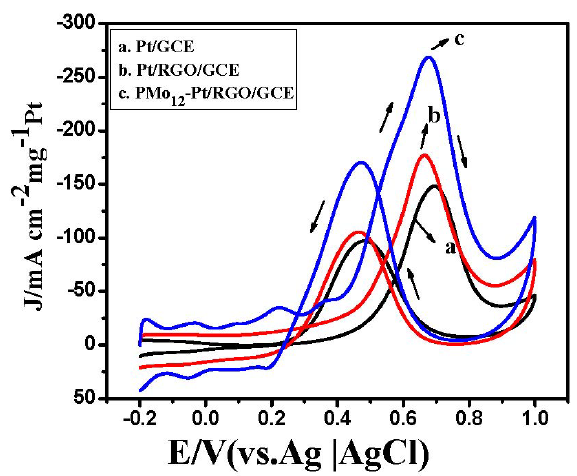
Figure 6. Cyclic voltammograms of different modified electrodes: ( a ) Pt/GCE; ( b ) Pt/rGO/GCE; ( c ) PMo 12 -Pt/rGO/GCE in 0.5 M H 2 SO 4 + 1 M CH 3 OH solution. Scan rate: 100 mV·s − 1